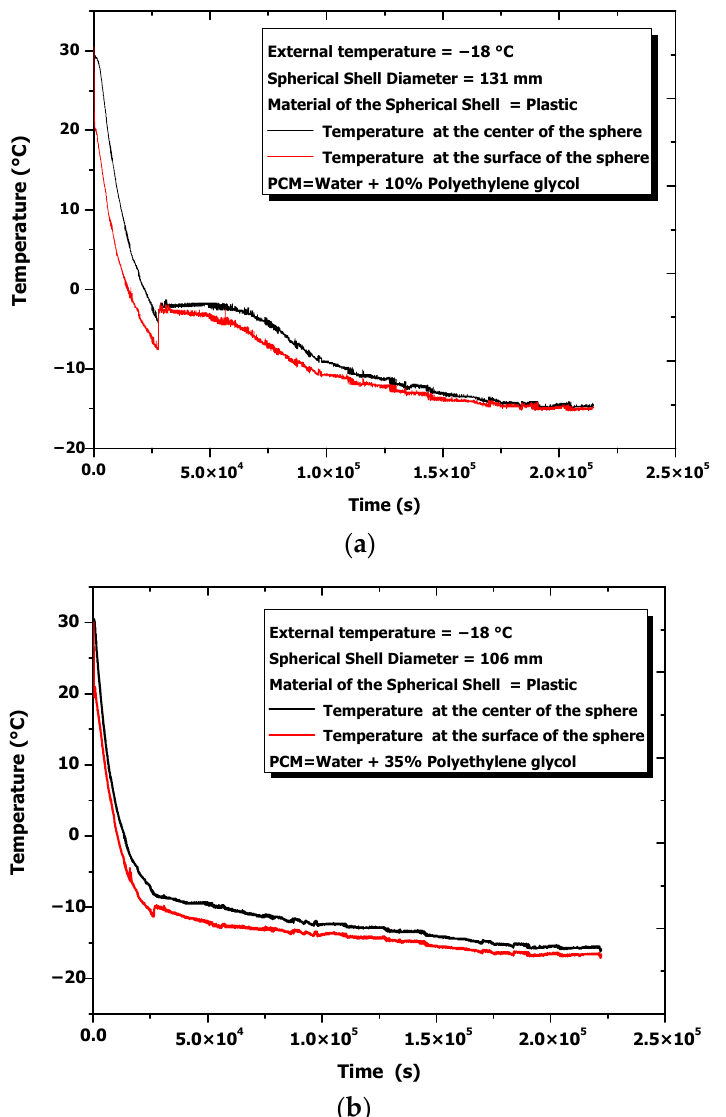
Figure 10. Change in the temperature at the center of the plastic spherical capsule during solidification of polyethylene glycol.